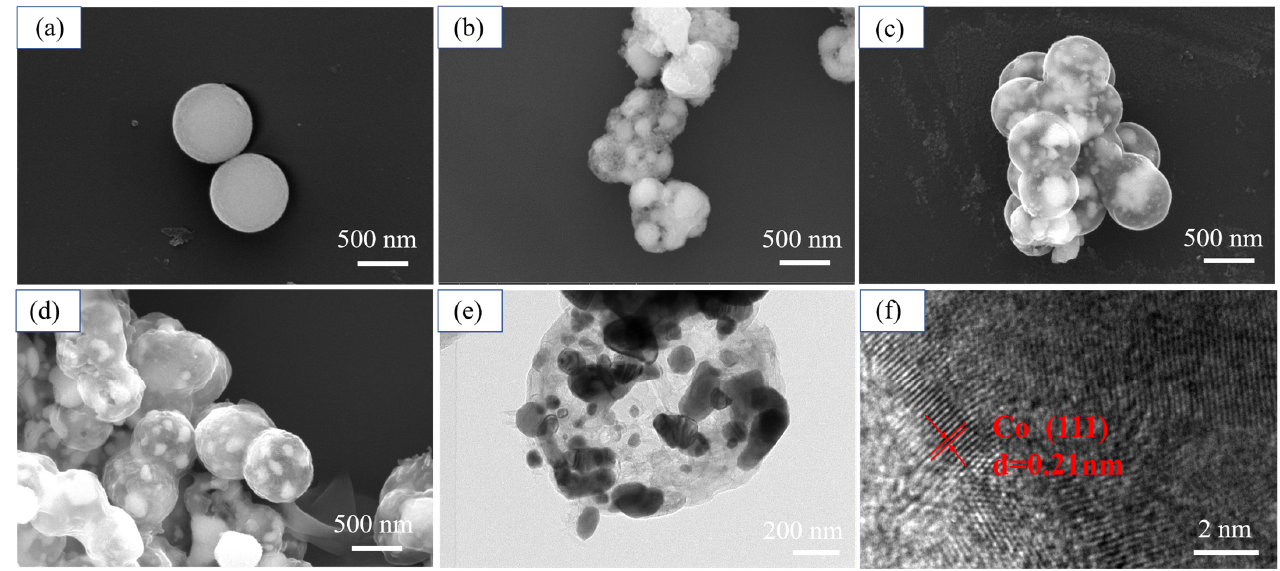
Figure 3. FE-SEM images of ( a ) Co 3 O 4 , ( b ) S1, ( c ) S2, ( d ) S3. TEM image of ( e ) S2. ( f ) HRTEM image of Co wrapped in carbon shell of S2.